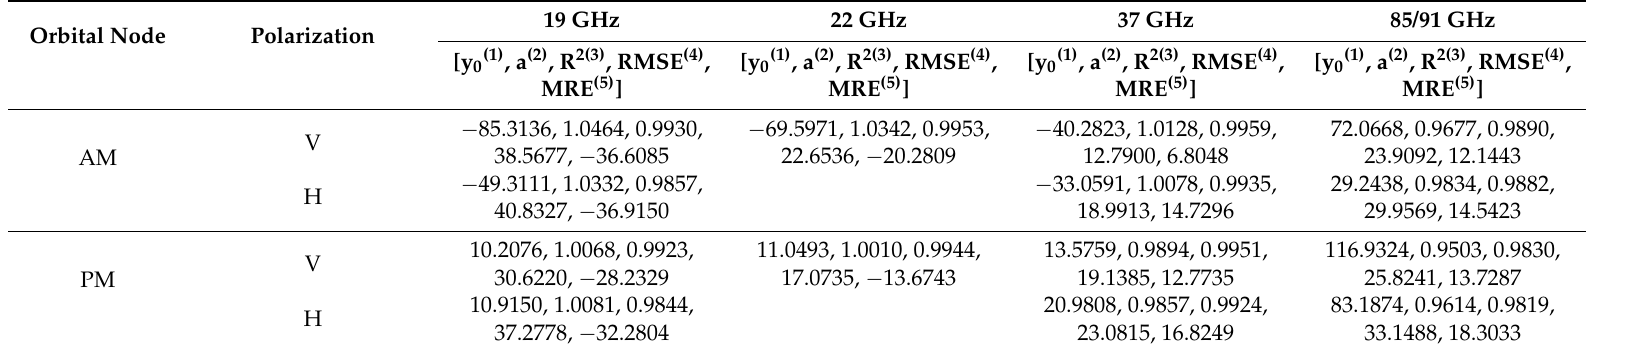
Table 1. Relationships between Special Sensor Microwave Imager/Sounder (SSMI/S) (v2) and Special Sensor Microwave Imager (SSM/I) (v1) brightness temperatures (K ˆ 10), during mission overlap (2007–2008), for A.M. and P.M. orbital nodes, vertical (V) and horizontal (H) polarizations, and the 19, 22, 37, and 85/91 GHz bands. Relationships are significant at a minimum 0.01 probability